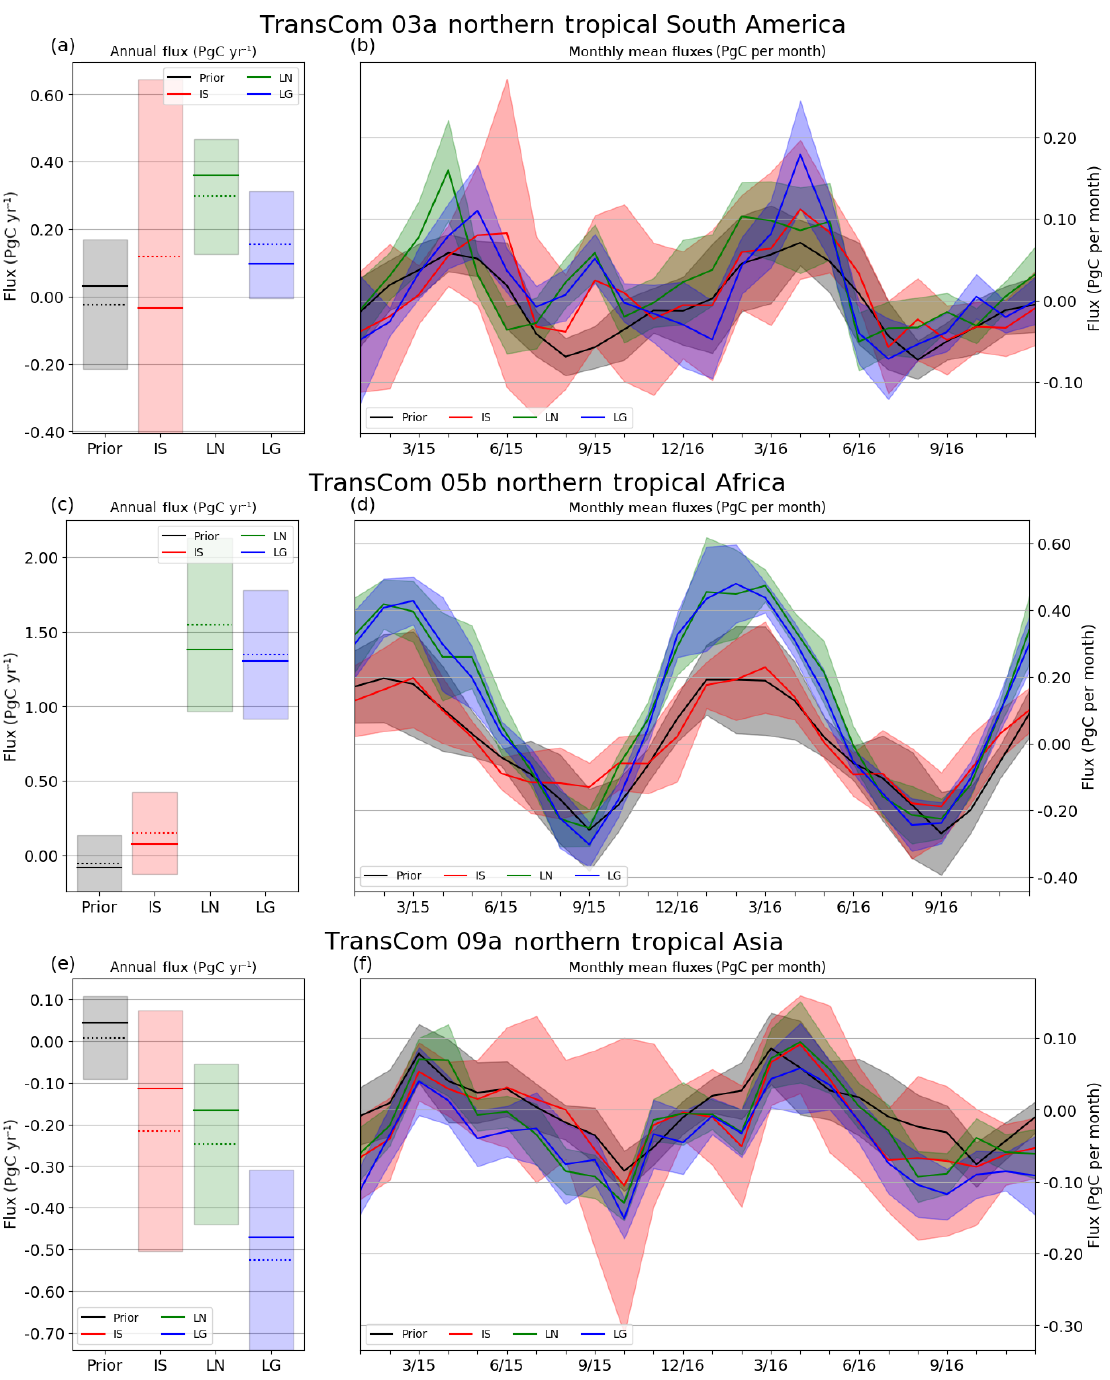
Figure 6. As in Fig. 3, but for selected terrestrial regions in the northern tropics on different continents. Among the three continents, satellite- derived posterior fluxes differ substantially from the prior and in situ-constrained fluxes only in northern tropical Africa, where the outgassing in the dry season is about double the magnitude. The phasing in the posterior fluxes is also different in southern tropical Africa, where the peak outgassing is shifted later in the year by a few